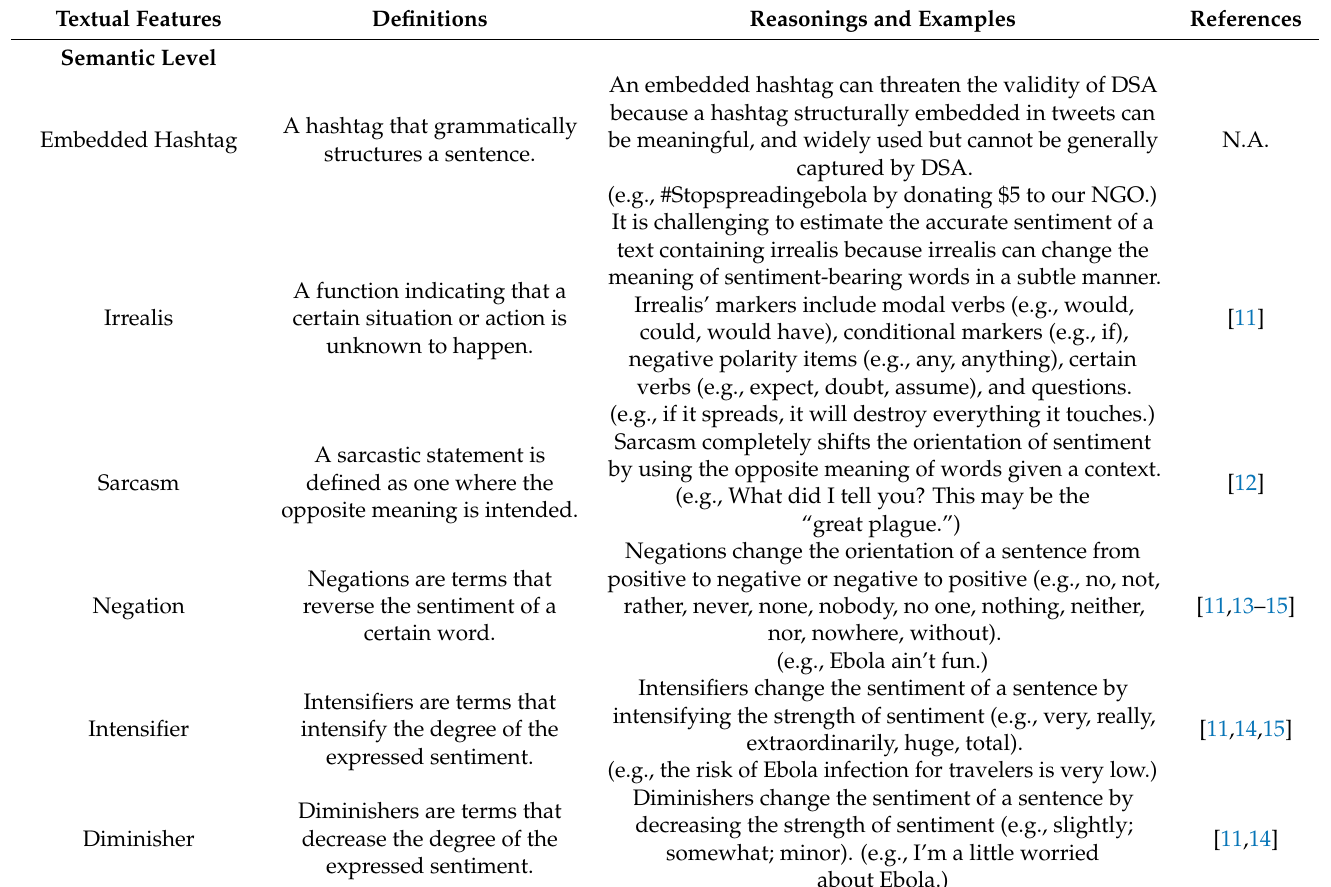
Table 1. Explanations and examples of textual